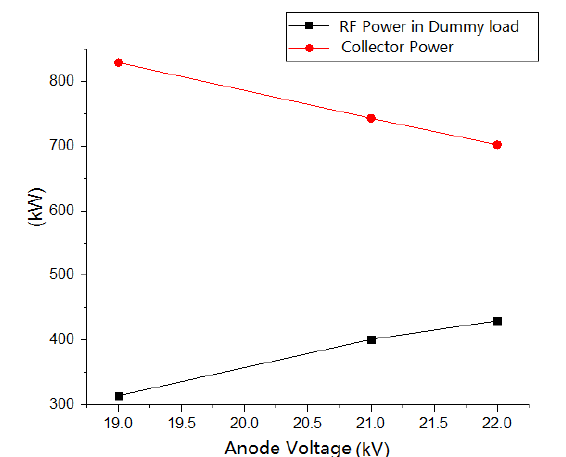
Fig. 9. Changes in the output power of the gyrotron when the magnetic field current, filament primary voltage, filament primary current, and cathode voltage are 50.55A, 39.1V, 34.4A, and -42kV, respectively.